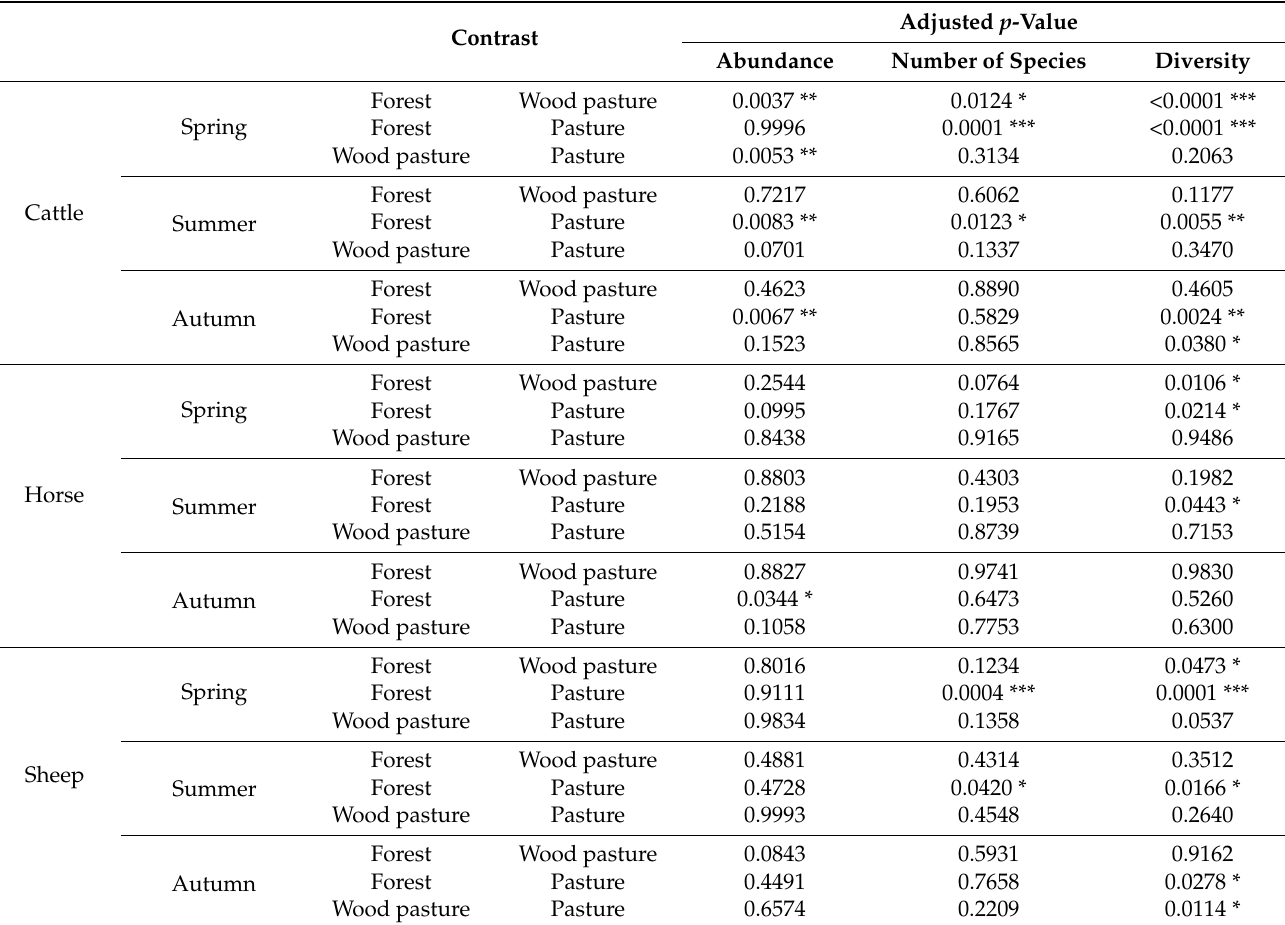
Table A2. Significance values for the comparisons in Figure 2, on dung beetle abundance and species number according to dung